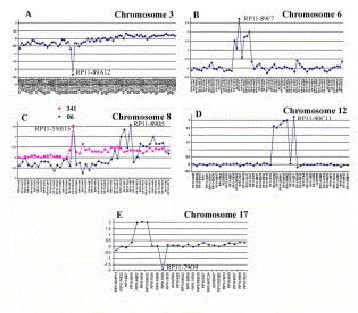
A representative chromosome profiles showing homozygous deletions (A, E) and high-level amplifications (B- E). The clones showing homozygous deletions from 3p14.1 (RP11-89A12) and 17q12 (RP11-79O9) in tumor 06 (A, E) and high-level amplifications from 6p12-p21 in tumor 248(B), 8q12 in tumors 06 and 341 and 8q23-q24 in tumor 06, (C), 12q13-q15 in tumor 48, (D) and 17p11.2 in tumor 06(E), are shown as log ratios (Y-axis). The clones on each chromosome are arranged (pter to qter) on the basis of UCSC mapping positions.